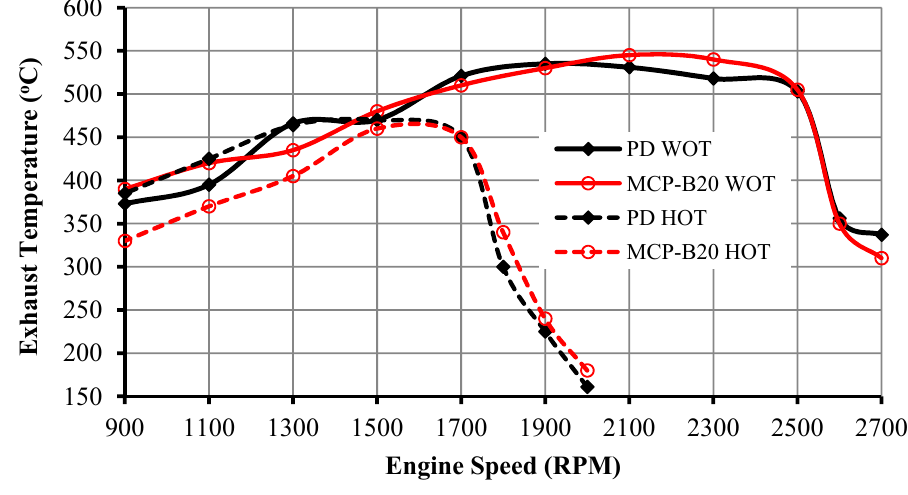
Figure 8. The relationship between tractor engine speeds (RPM) and exhaust temperature (°C) for PD and MCP-B20.